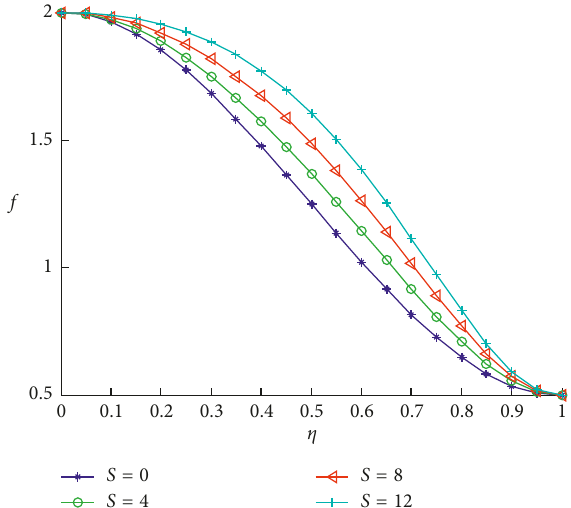
Figure 7: Effect of the squeezing parameter on the velocity profile when A Pr